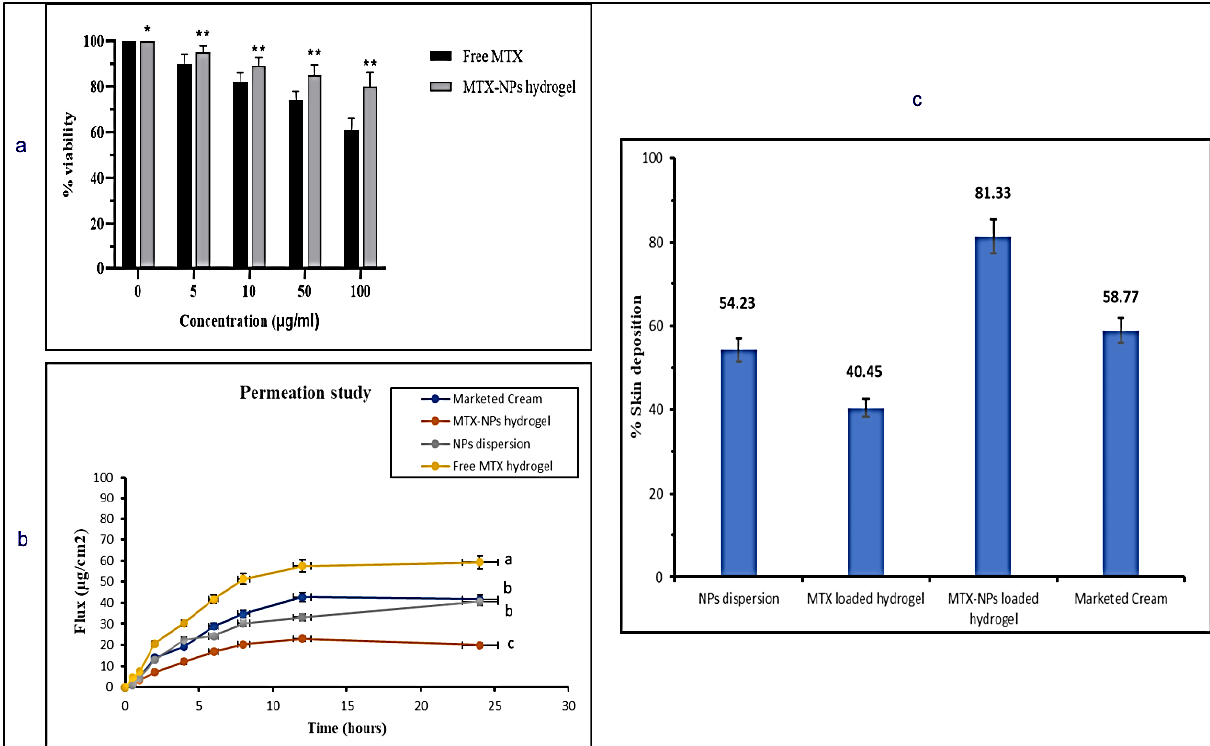
Figure 8. ( a ) In vitro cell viability assay in blood lymphocytes treated with free MTX and MTX - NPs loaded hydrogel. Results are indicated as mean ± SD, n = 3. * p < 0.05, ** p < 0.01, ( b ) Percent cumulative drug permeation of free MTX hydrogel, NPs dispersion, MTX - NPs hydrogel and marketed cream. Data has been represented as mean ± SD where different superscripts ( a – c ) represent significant difference ( p < 0.05) between various formulations, ( c ) Percent skin deposition of free MTX hydrogel, NPs dispersion, MTX - NPs hydrogel and marketed cream.